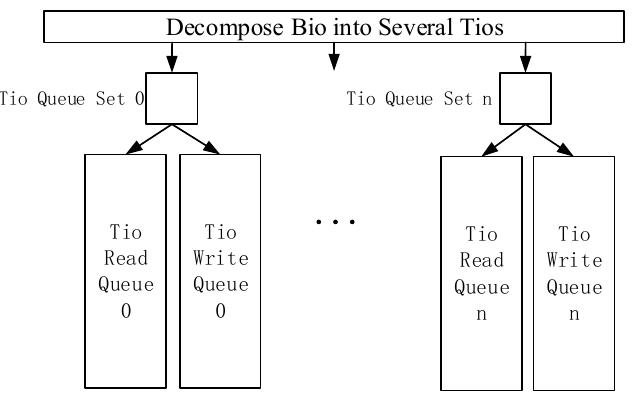
Figure 3. Multi-queue management strategy.